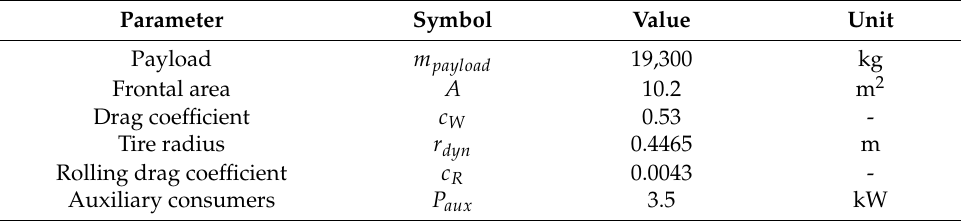
Table 3. Assumptions of input parameters for vehicle simulation [52,53].